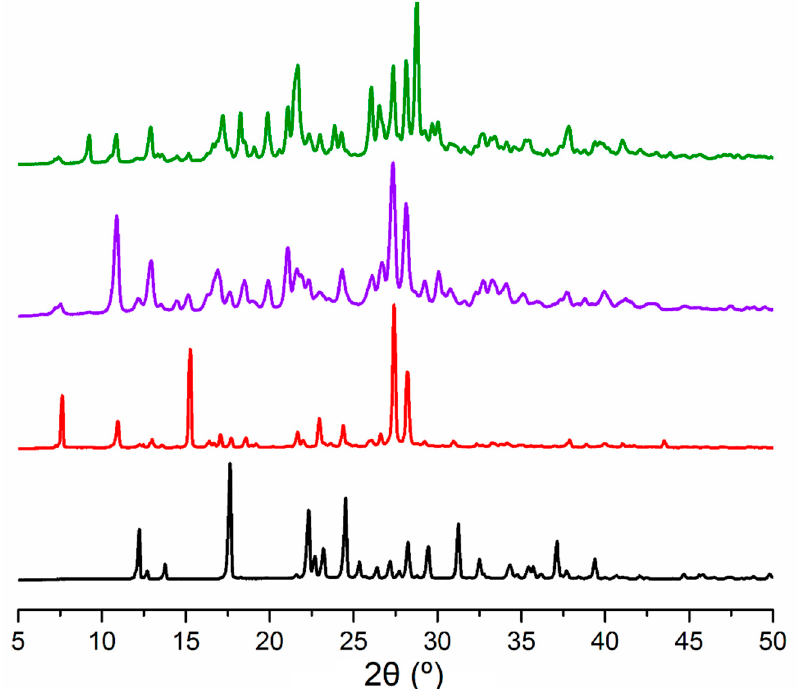
Figure 1. XRPD patterns of ( a ) pristine HMfCl, ( b ) H 2 Mf(HpOXA) 2 · 4W organic salt (experimental), ( c ) mechanochemical synthesis in 1:1 proportion of HMfCl / H 2 pOXA, and ( d ) mechanochemical synthesis in 1:2 proportion of HMfCl / H 2